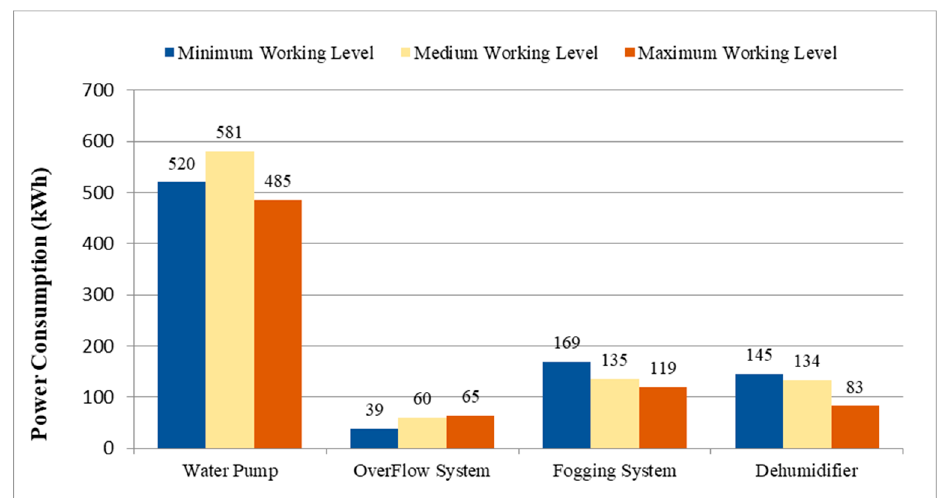
Figure 17. Comparative analysis of the actuators’ energy consumption results.